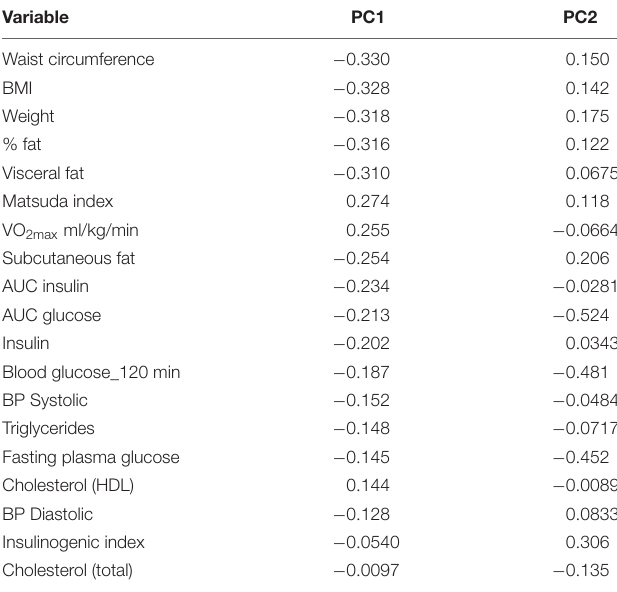
TABLE 5 | Loading of the variables in the two principal components, sorted by the magnitude of the loadings in PC